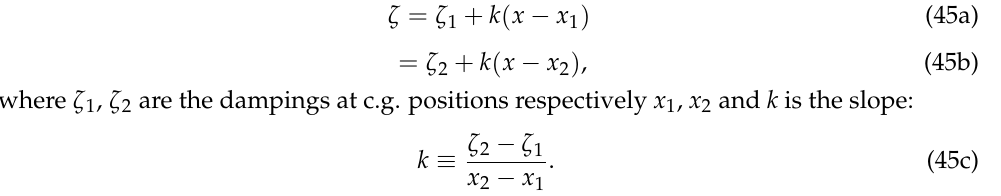
Table 12. Longitudinal and lateral maneuver